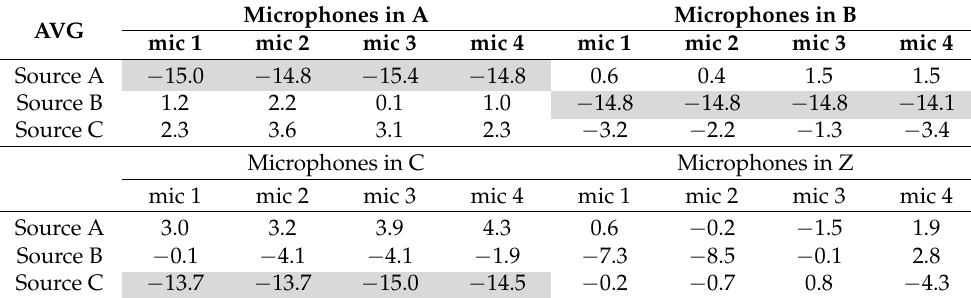
Table 11. Total support ST Total (frequency averaged).